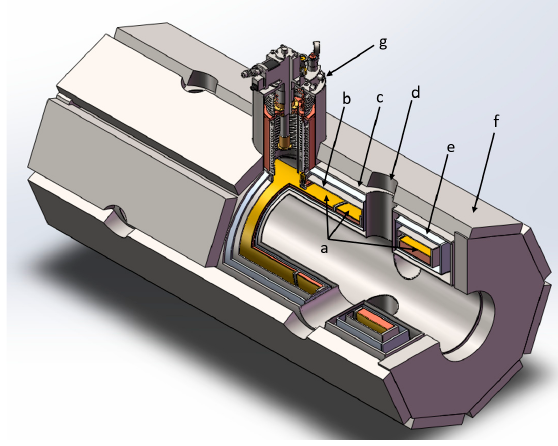
Figure 4. The design plan of the superconducting magnet subsystem, with superconducting coils ( a ) wrapped with two layers of Dewar ( b , c ) and a layer of thermal insulation cold shield ( e ), and the magnets wrapped with magnetic shielding iron shield ( f ) with eight radially distributed room temperature ports ( d ), as well as a service tower ( g ) on the top.